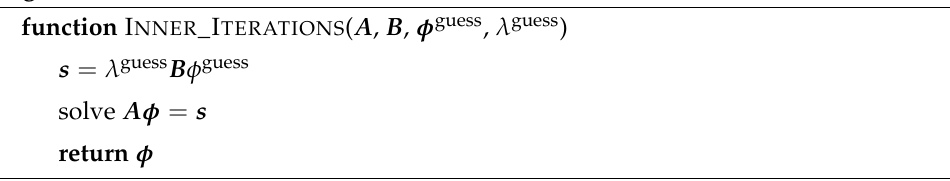
Algorithm 1 Power method: inner iterations.